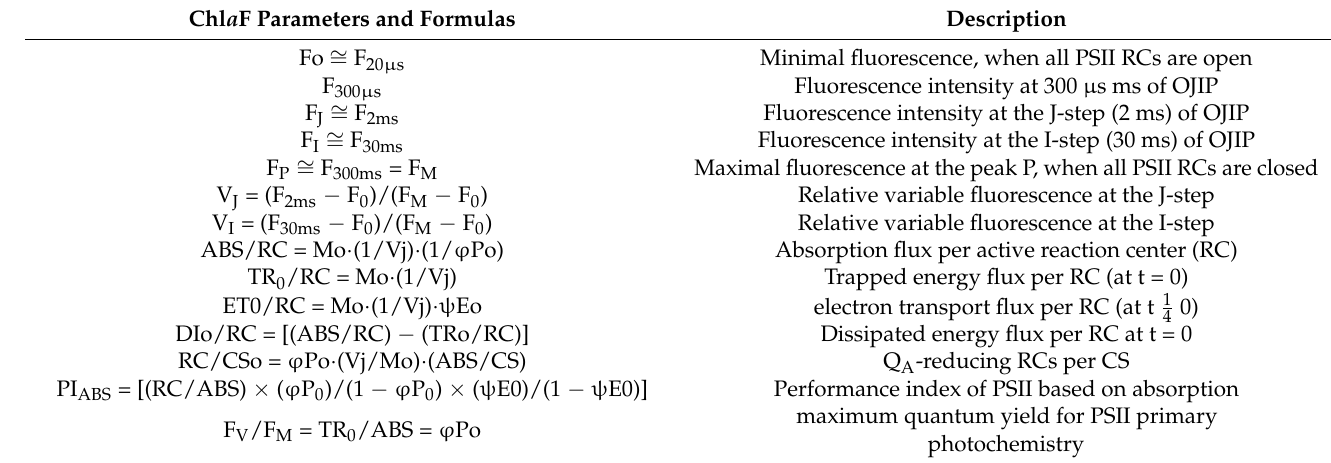
Table 7. Abbreviations of the parameters, formulas and description of the data derived from the transient of Chla